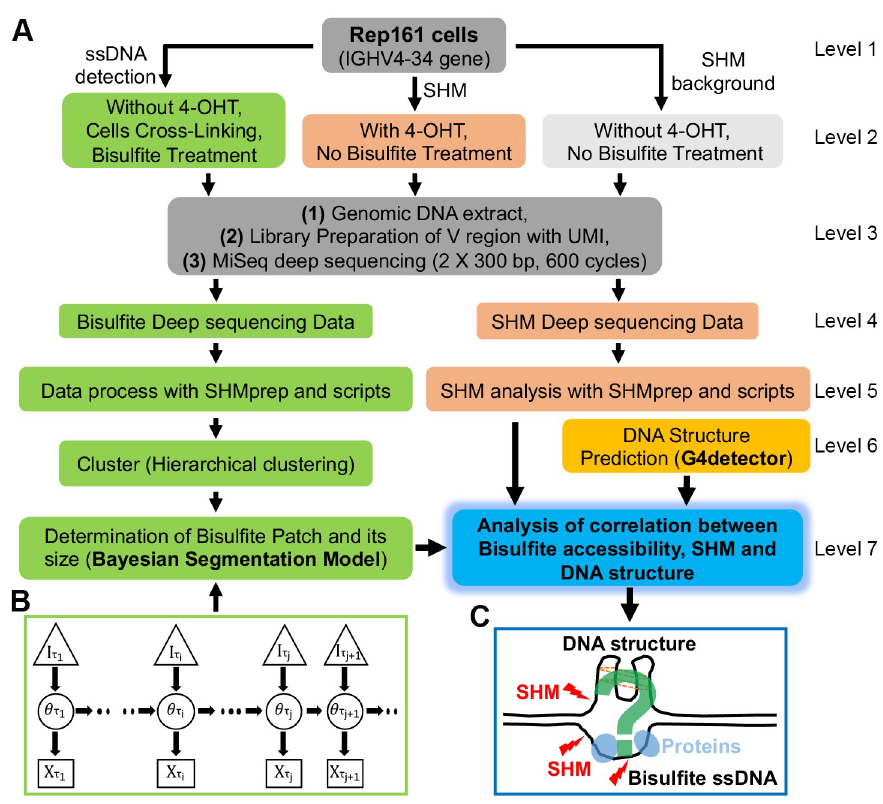
Fig 1. Pipeline and schema of the novel Bayesian segmentation model developed for this study. Overall, this study includes 5 parts: (A, level 1–3), Separate preparation of libraries with UMI for both bisulfite accessible ssDNA and SHM and deep sequencing using Illumina MiSeq. (A, left part of level 4–7 in green background and panel B), Using the Bayesian segmentation model to determine the BARs; (A, right part of level 4–5), Calculate SHM from the same cell line; (A, right part of level 6), Predicting G-quadruplex structures for IGHV4–34 gene; (A, right part of level 7 and panel C) Studying the spatial correlation between BARs and G-quadruplex to analyze the relationship between BARs and SHM at a base-pair resolution. A detailed explanation for this Bayesian segmentation model can be found in the main text (Results). In panel C, red lightning marks represent SHM by AID and panel C is a cartoon illustrating the possible correlation among SHM, BARs and the DNA structure. ssDNA: single stranded DNA. SHM: somatic hypermutation. 4-OHT: 4-Hydroxytamoxifen. UMI: unique molecular